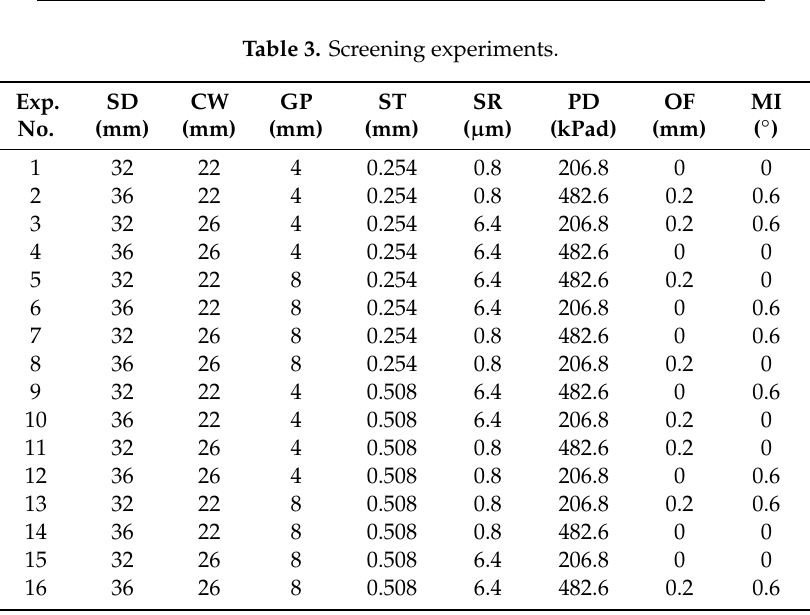
Table 3. Screening